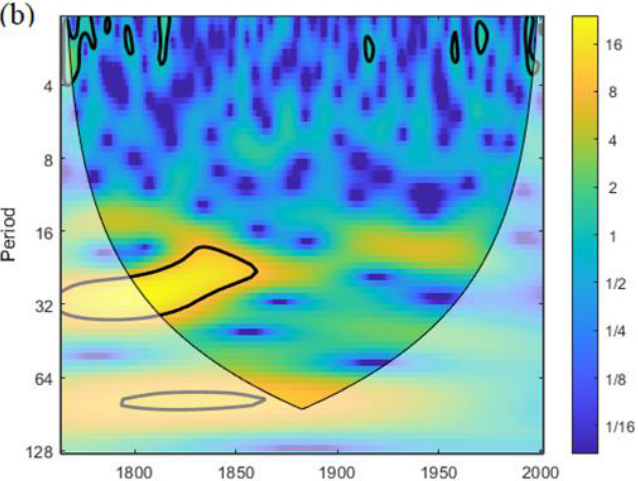
Figure 6. Multiple-taper method (MTM) spectral analysis ( a ) and wavelet analysis ( b ) of the recon- structed July temperature. The blue (red) solid line shows the 95% (90%) confidence level in ( a ); the black line in ( b ) denotes the 95% confidence level.